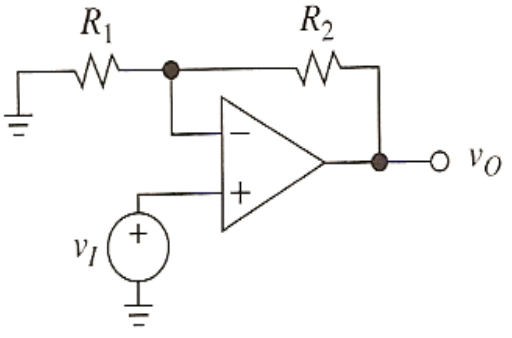
Figure 3. Summing amplifier used as the primary conditioning